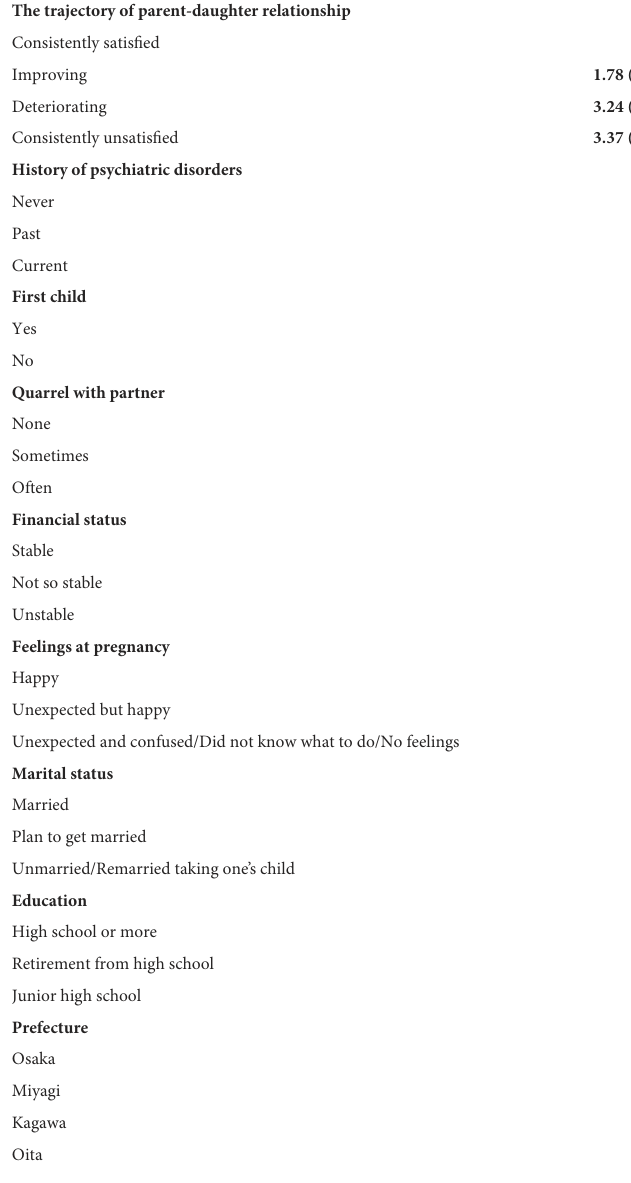
Valuesareoddsratioswith95%confidenceintervalsgiveninparenthesesestimatedwithmultivariablebinarylogisticregressionanalyses. Model1:Adjustedforagegroup. Model2:Model1 + adjustedforhistoryofpsychiatricdisorders. Model3:Model2 + adjustedforpregnancydemographics(firstchild,economicstatus,feelingsatpregnancy,quarrelwithpartner,maritalstatus,education,andprefecture).